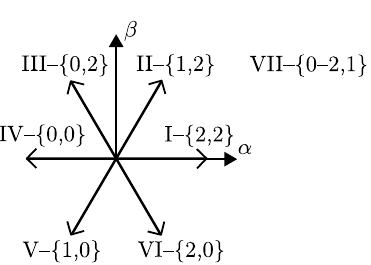
Figure 5. Voltage space vectors of the series converter (for non-zero ‘dc link’ voltage) in the αβ frame with the corresponding sliding variable values